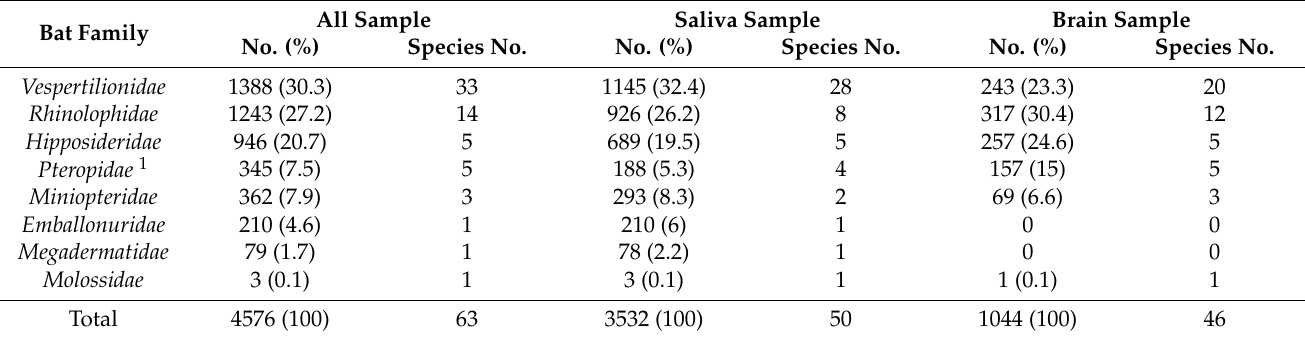
1 Bats belonging to this family are frugivorous; all other bat species tested in this study are